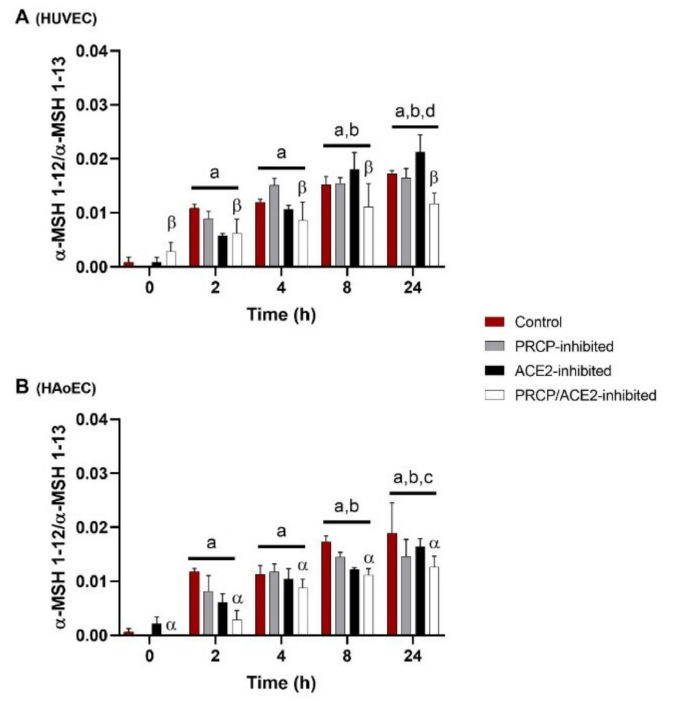
Figure 2. α -MSH 1–13 is cleaved at its C-terminus in function of time in HUVEC and HAoEC. C-terminal cleavage of α -MSH 1–13 to α -MSH 1–12 in HUVEC ( A ) and HAoEC ( B ) ( n = 4 per group), expressed as the ratio of the peak intensity of α -MSH 1–12 to the peak intensity of α -MSH 1–13 measured in the supernatant. Two-way ANOVA analysis showed no significant interaction between the effects of treatment duration and treatment option on the ratio of the peak intensities for the C-terminal cleavage of α -MSH 1–13 ( p = 0.159 for HUVEC and p = 0.596 for HAoEC) in both types of endothelial cells. For the treatment groups ( p = 0.029 for HUVEC and p < 0.001 for HAoEC) and the time point groups ( p < 0.001), significant main effects were reported. Results are reported as mean ± SEM. Significant p -values are indicated on the graph (a: different from 0 h, p < 0.001; b: different from 2 h, p < 0.001; c: different from 4 h, p < 0.01; d: different from 4 h, p < 0.05; α : different from control, p < 0.01; β : different from PRCP-inhibited group, p < 0.01; overall